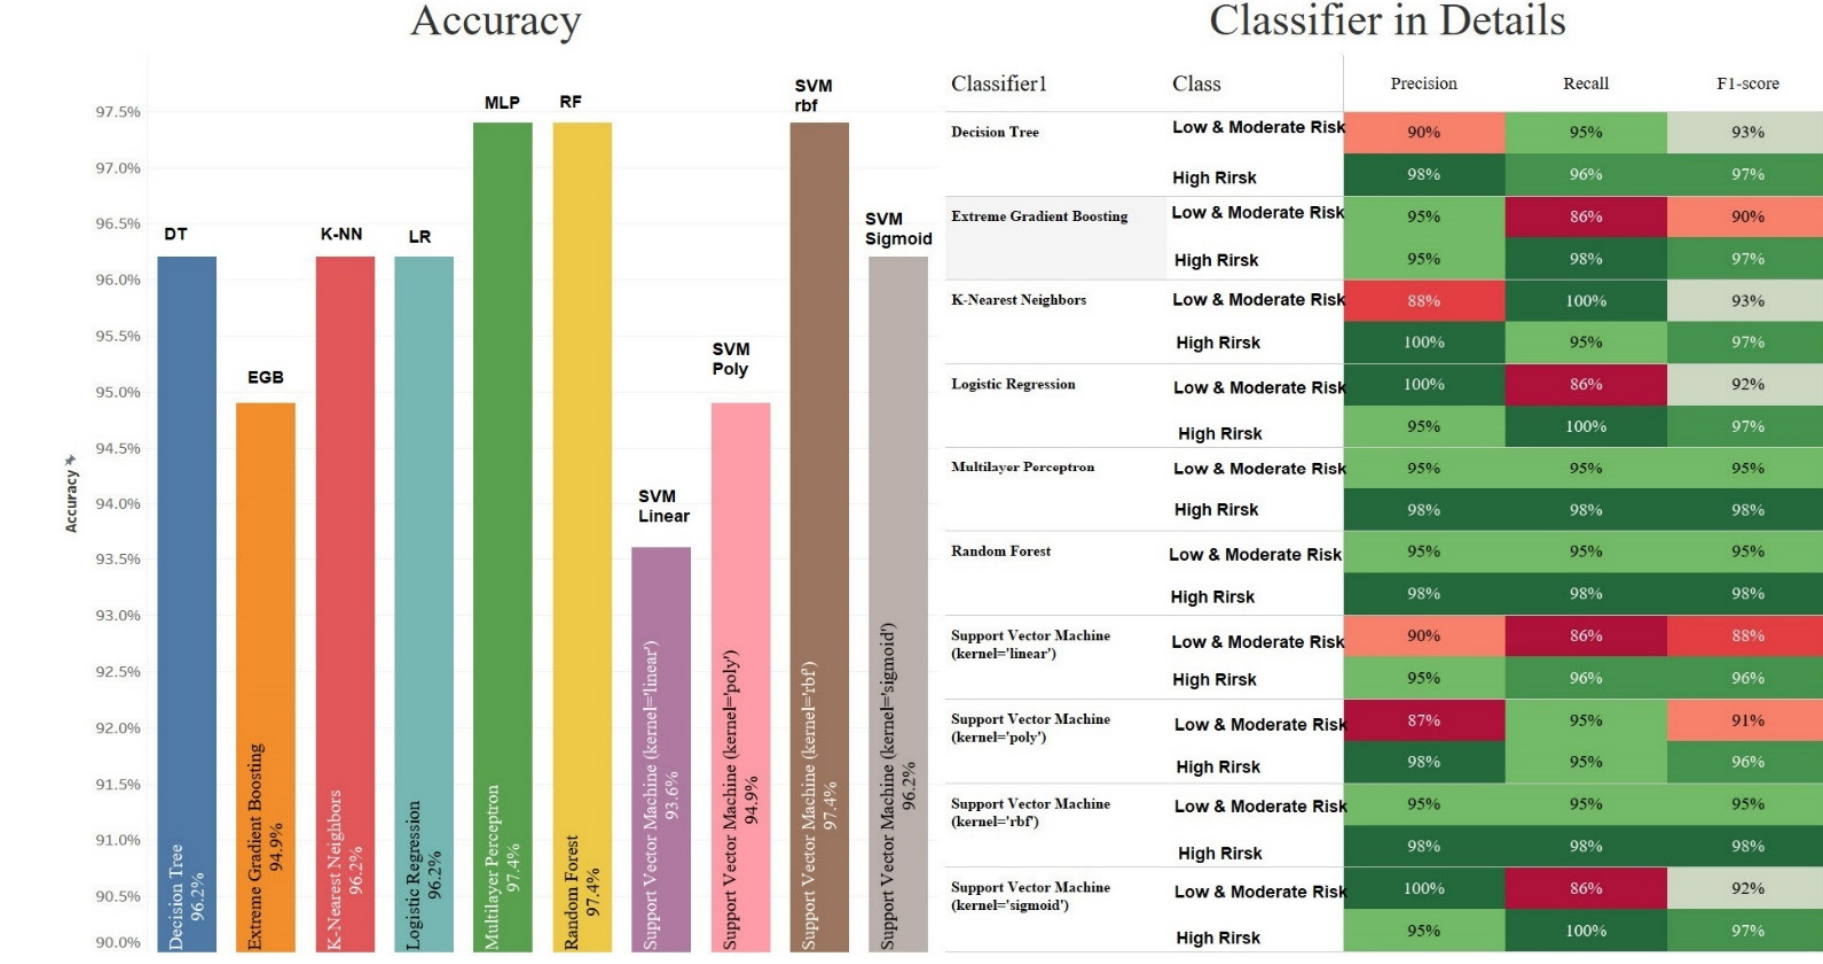
Figure 4. Accuracy of classifiers for 2 different types of risks with the Leave-One-Out Cross-Validation method.